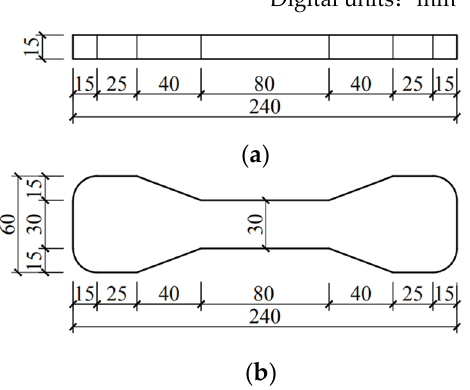
Figure 3. Schematic diagram of uniaxial tensile specimen: ( a ) profile; ( b ) plan.